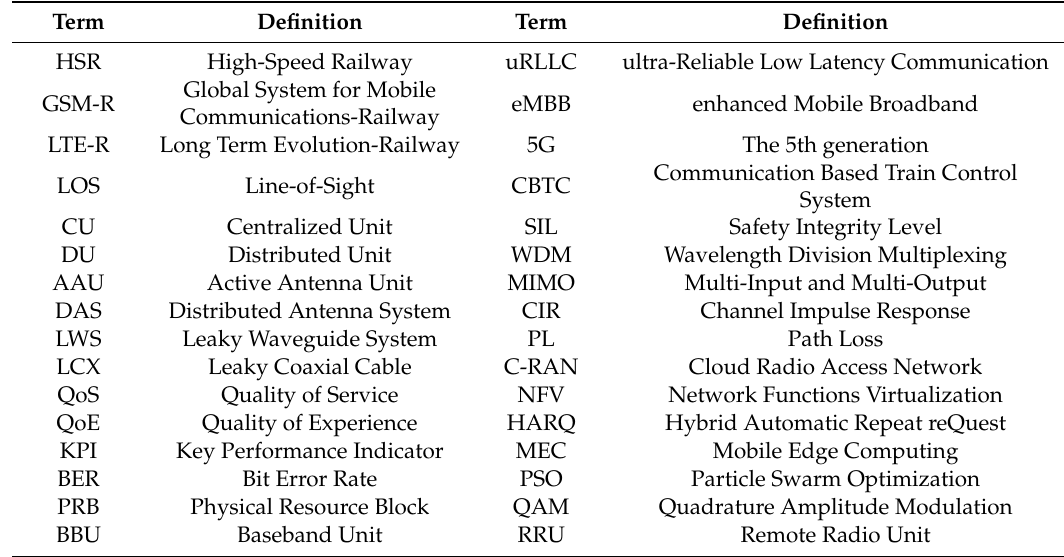
Table 1. Abbreviations and